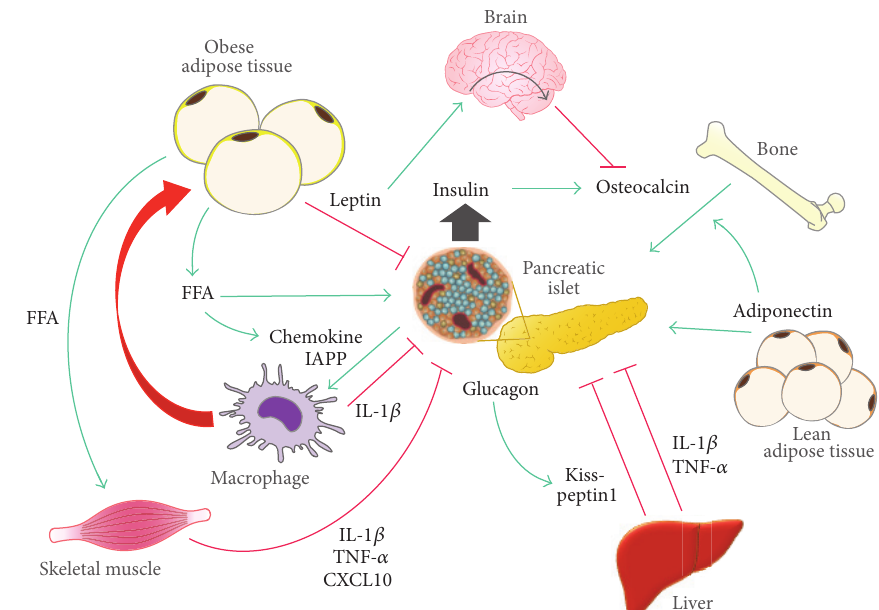
Figure 1: The interorgan crosstalk involved in 𝛽 -cell failure. Representative pathways from metabolic organs involved in a reduction of functional 𝛽 -cell mass are illustrated. Although adiponectin, preferentially secreted from lean adipose tissue, may have protective effects on 𝛽 -cells, leptin, which is secreted more from obese adipose tissue, negatively impacts 𝛽 -cell function and mass via direct and indirect pathways. Leptin suppresses the bioactivity of osteocalcin, which is essential for 𝛽 -cell function and expansion, through the modulation of sympathetic tone signals delivered to osteoblasts, creating a feed-forward interplay among adipose tissue, the brain, bone, and 𝛽 -cells. Conversely, insulin enhances osteocalcin bioactivity through the activation of osteoclastic bone resorption. Meanwhile, excess FFA spillover from obese adipose tissue induces insulin resistance in insulin sensitive organs such as muscle and liver, resulting in overload of 𝛽 -cells by excess insulin demand. Additionally, skeletal muscle and liver might exert detrimental effects of 𝛽 -cell function by secreting proinflammatory cytokines and chemokines in this setting. Glucagon promotes Kisspeptin 1 production in hepatocyte, which mediates an alternative pathway from liver to 𝛽 -cells. Furthermore, FFA induces the production of chemokines in 𝛽 -cells, recruiting M1 macrophages into islets. In the diabetic milieu, hyperglycemia and IAPP derived from 𝛽 -cells synergistically promote inflammatory responses through the promotion of IL-1 𝛽 biosynthesis in M1